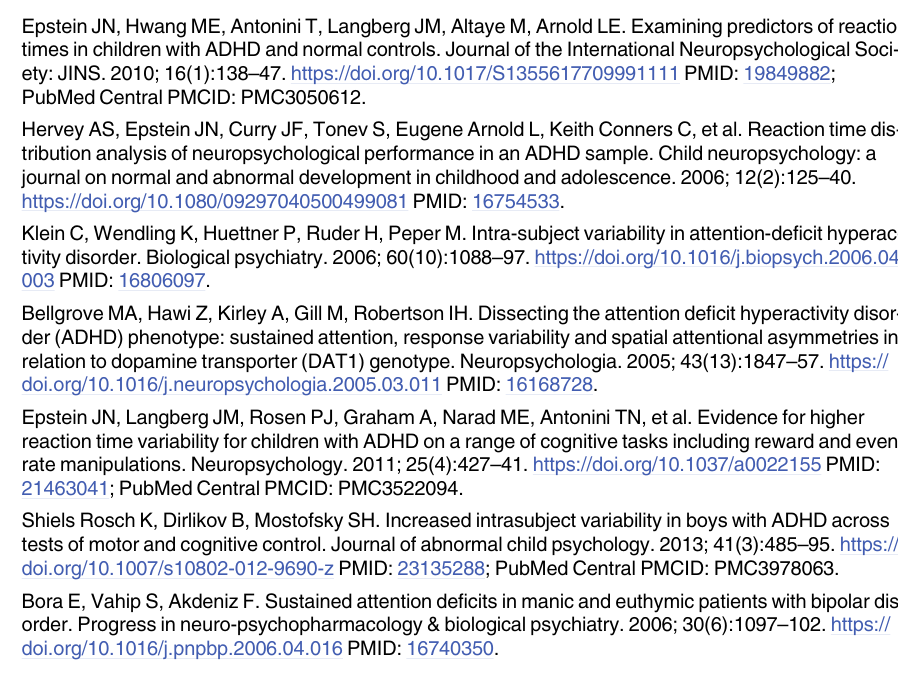
S1 Table. Differences in Eriksen flanker task (EFT) RT-mean, RT-SD and RT-CV values across the three